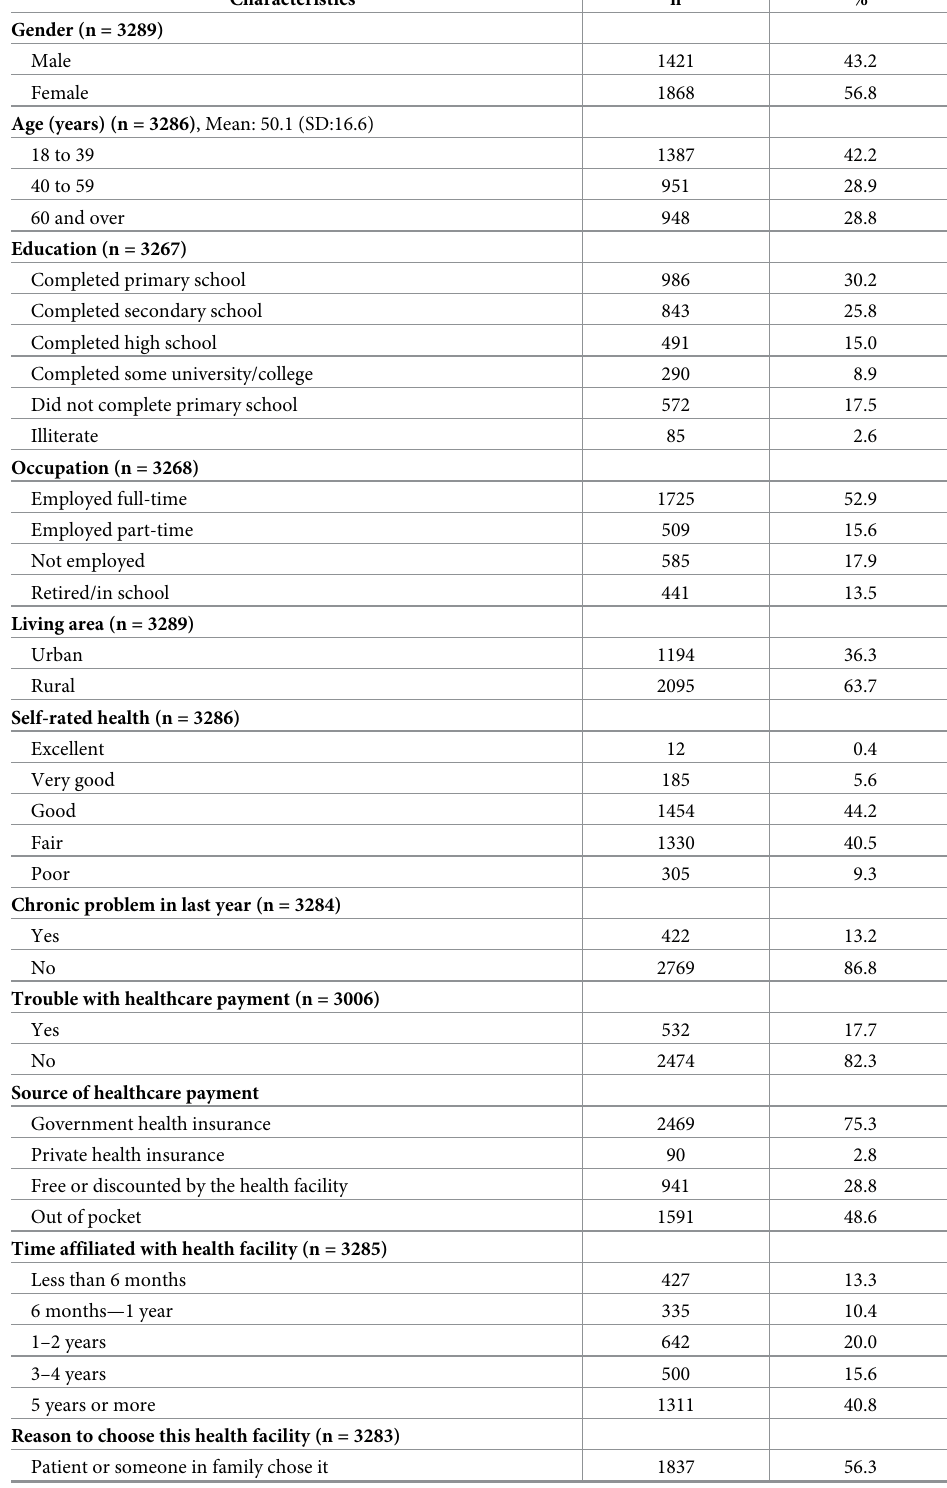
Table 2. Characteristics of the participants (n =